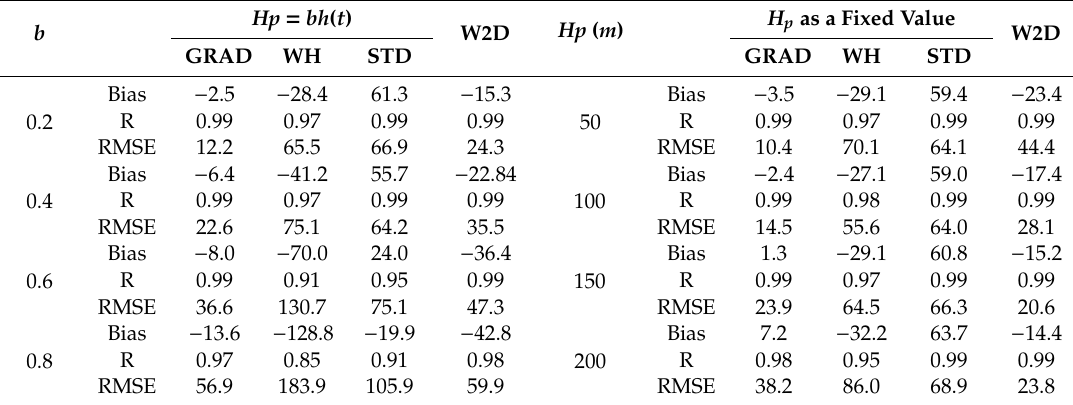
Table 3. Method evaluations with di ff erent Hp as H p = bh ( t ).